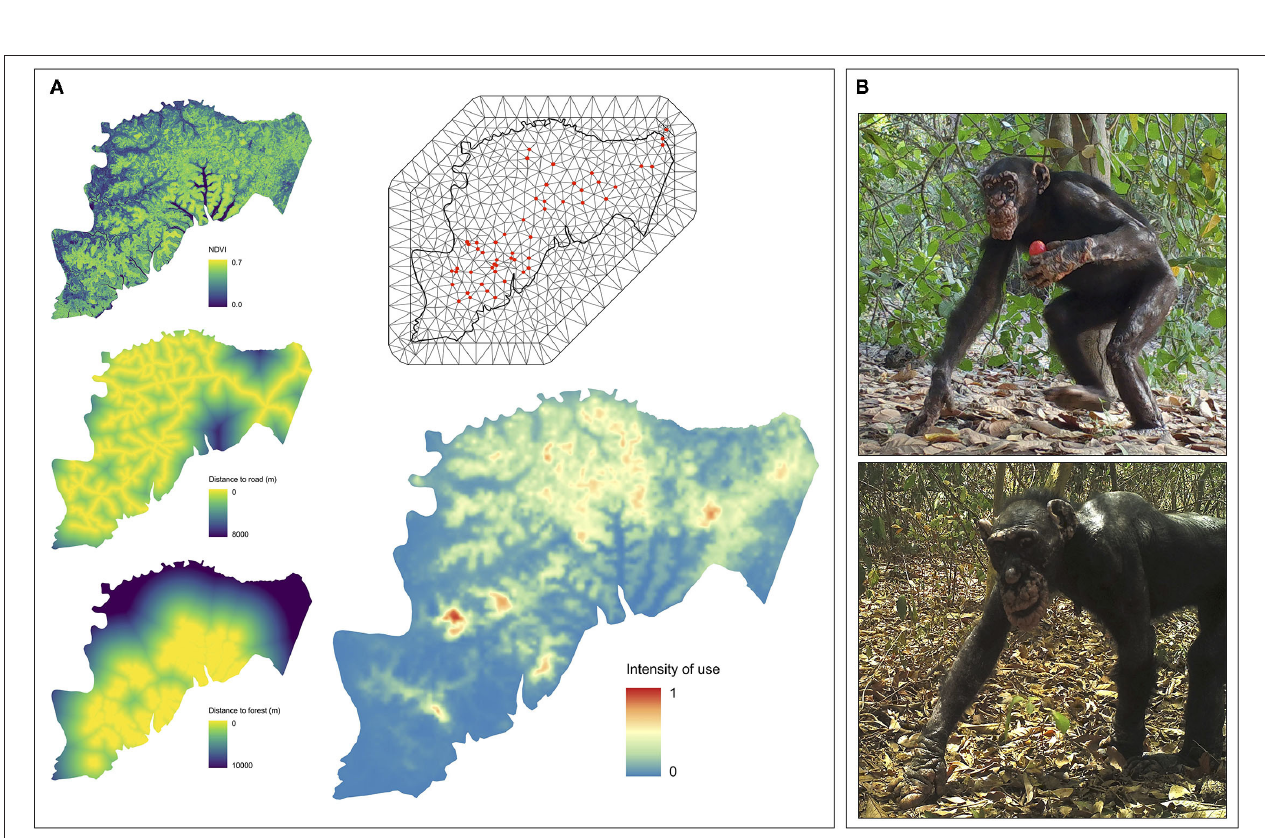
FIGURE 2 | to monitor disease in wildlife in Cantanhez NP is increased to 80% compared to baseline (zero) through the implementation of biodiversity monitoring and the establishment of an IBAP surveillance team for sample collection and management of animal carcasses; (Output 1—Health Campaign) By the end of Year 3, at least 50% of campaign participants ( N = 30 out of 60, including at least 50% women) demonstrate increased understanding in the links between environmental, animal and human health via One Health trial campaign in six partner villages compared to baseline pre-campaign; (Output 2—BHMP) By Year 2, the wildlife monitoring capacity in Cantanhez NP is increased to 80% compared to baseline 5% (based on number of park staff trained to record and analyse data, and existing training manuals); (Output 3—One Health plan) By the middle of Year 3, key wildlife habitat including corridors, and areas of high human–wildlife interaction and potential disease transmission are identified, and; by the end of Year 3, the plan is developed with stakeholders (Management Committee and other group representatives including from the Cantanhez Women’s Associations) comprising at least 50% women; (Output 4—Leprosy response plan) By the end of Year 3, institutional capacity to sample, handle and dispose wild animal carcasses securely is increased by 100% compared to baseline zero; By Year 4, institutional knowledge to manage and respond to conflicts over leprosy disease (including mistrust of health services, retaliatory behaviour towards animals) and leprosy in humans is increased via the production of the first multi-stakeholder leprosy response plan in Guinea-Bissau. This project includes different health and conservation partner Institutions and Organisations in Guinea-Bissau, including the Institute for Biodiversity and Protected Areas, (IBAP), the Associação Nacional para o Desenvolvimento Local e Urbano (NADEL), and in Europe, including the University of Exeter in the United Kingdom, the Centre for Research in Anthropology in Portugal, and the Robert Koch Institute in Germany. Local partners include the women’s groups and the local management committee, which is actively involved in the management of the park alongside IBAP.